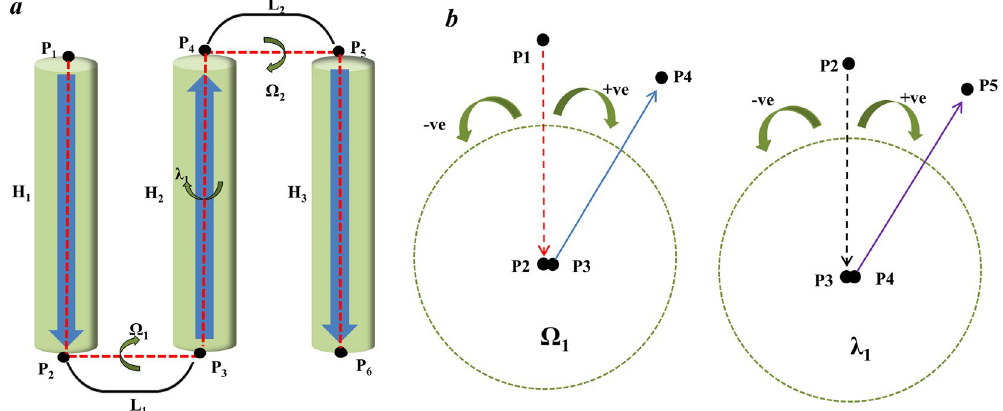
Figure 2. Joint-based description of membrane proteins with three helices and two loops. ( a ) Assignment of the Ω type and λ type dihedral angles. H 1 to H 3 are helices, L 1 to L 2 are loops, and P 1 to P 6 are joint points. Ω-type dihedral angles, such as Ω 1 , are defined by the four joint points in the Helix-Loop-Helix, such as P 1 , P 2 , P 3 , and P 4 . The λ -type dihedral angles, such as λ 1 , are defined by the four joint points in the Loop-Helix-Loop, such as P 2 , P 3 , P 4 and P 5 . ( b ) Assignment of the positive and negative signs for dihedral angles. The positive ( + ) sign and negative ( − ) signs represent the clockwise and counter-clockwise angles, respectively, in the projections for the dihedral angles. The figures present the projections for Ω 1 and λ 1